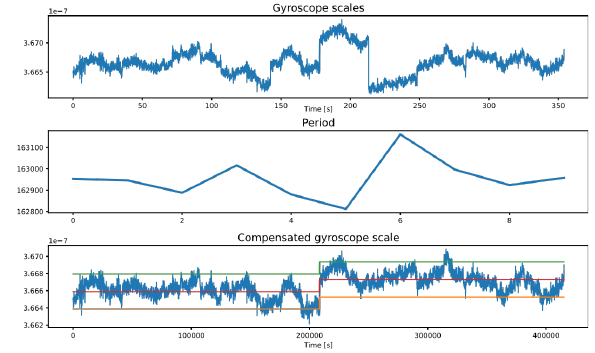
Fig. 7. Gyroscope calibration constants and period.